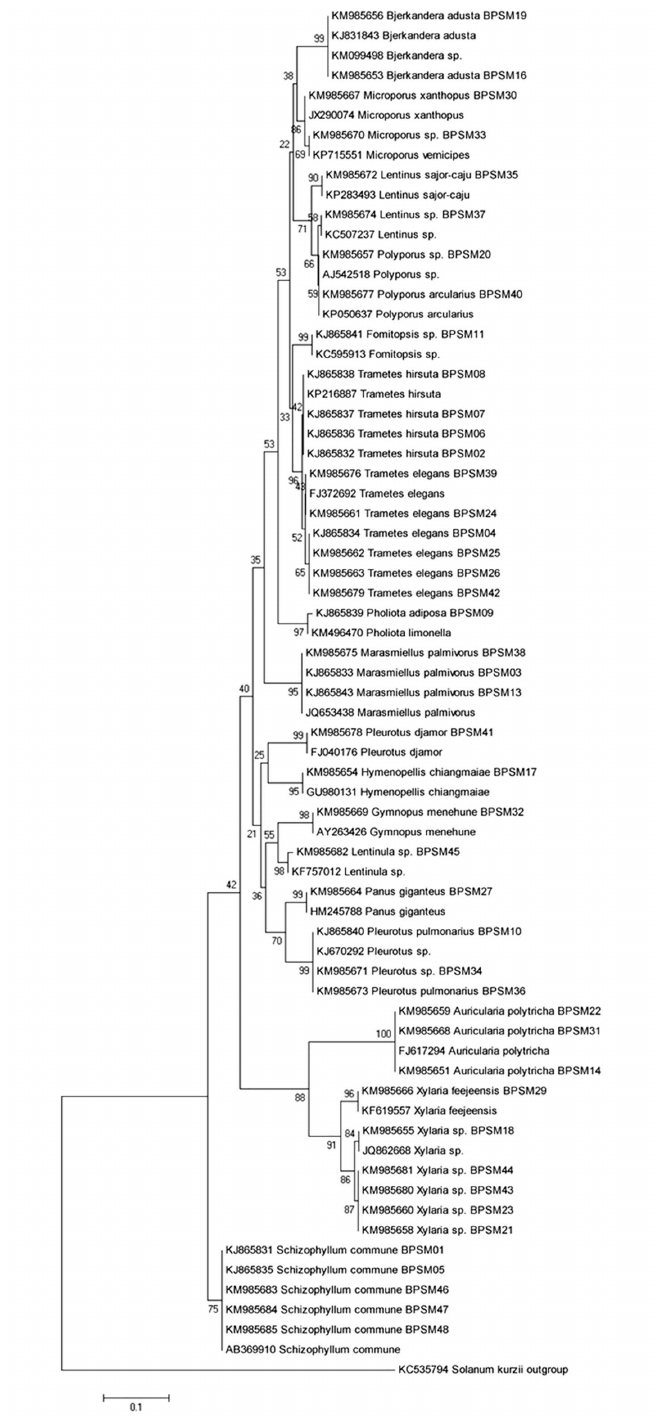
Fig 5. Neighbor-joining phylogenetic treeusing Kimura 2-parameter model based on ITS gene sequence of wild edible mushrooms. Numbers at branchesindicate bootstrapvalues of neighborjoining analysis( > 50%)from 1,000